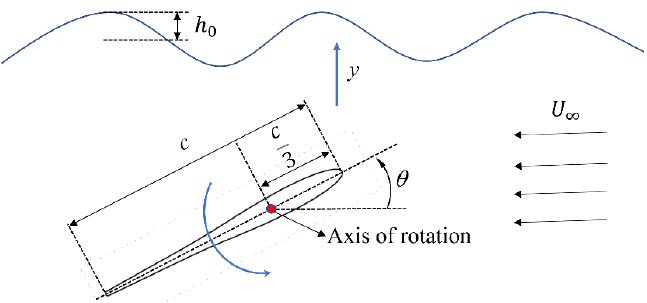
Figure 2. Schematic illustration of the coupled motion of the hydrofoil.